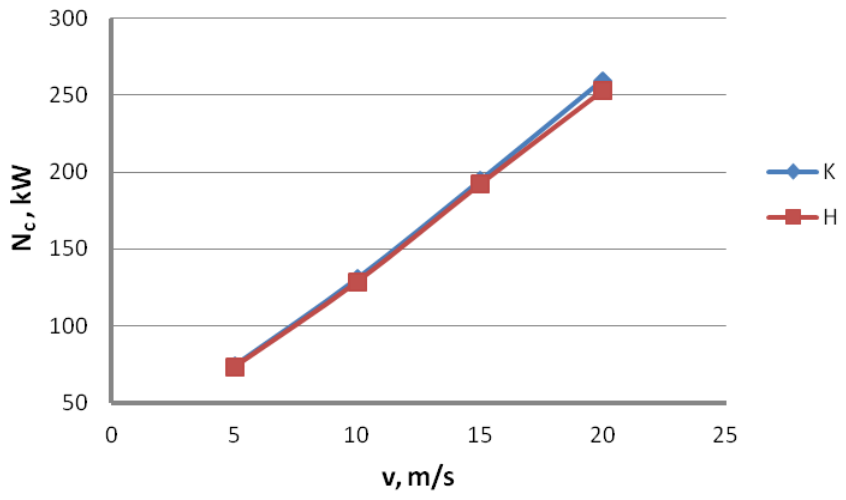
Figure 8. Total drawing power N c as a function of the drawing speed for the wires manufactured using conventional K and hydrodynamic H methods.